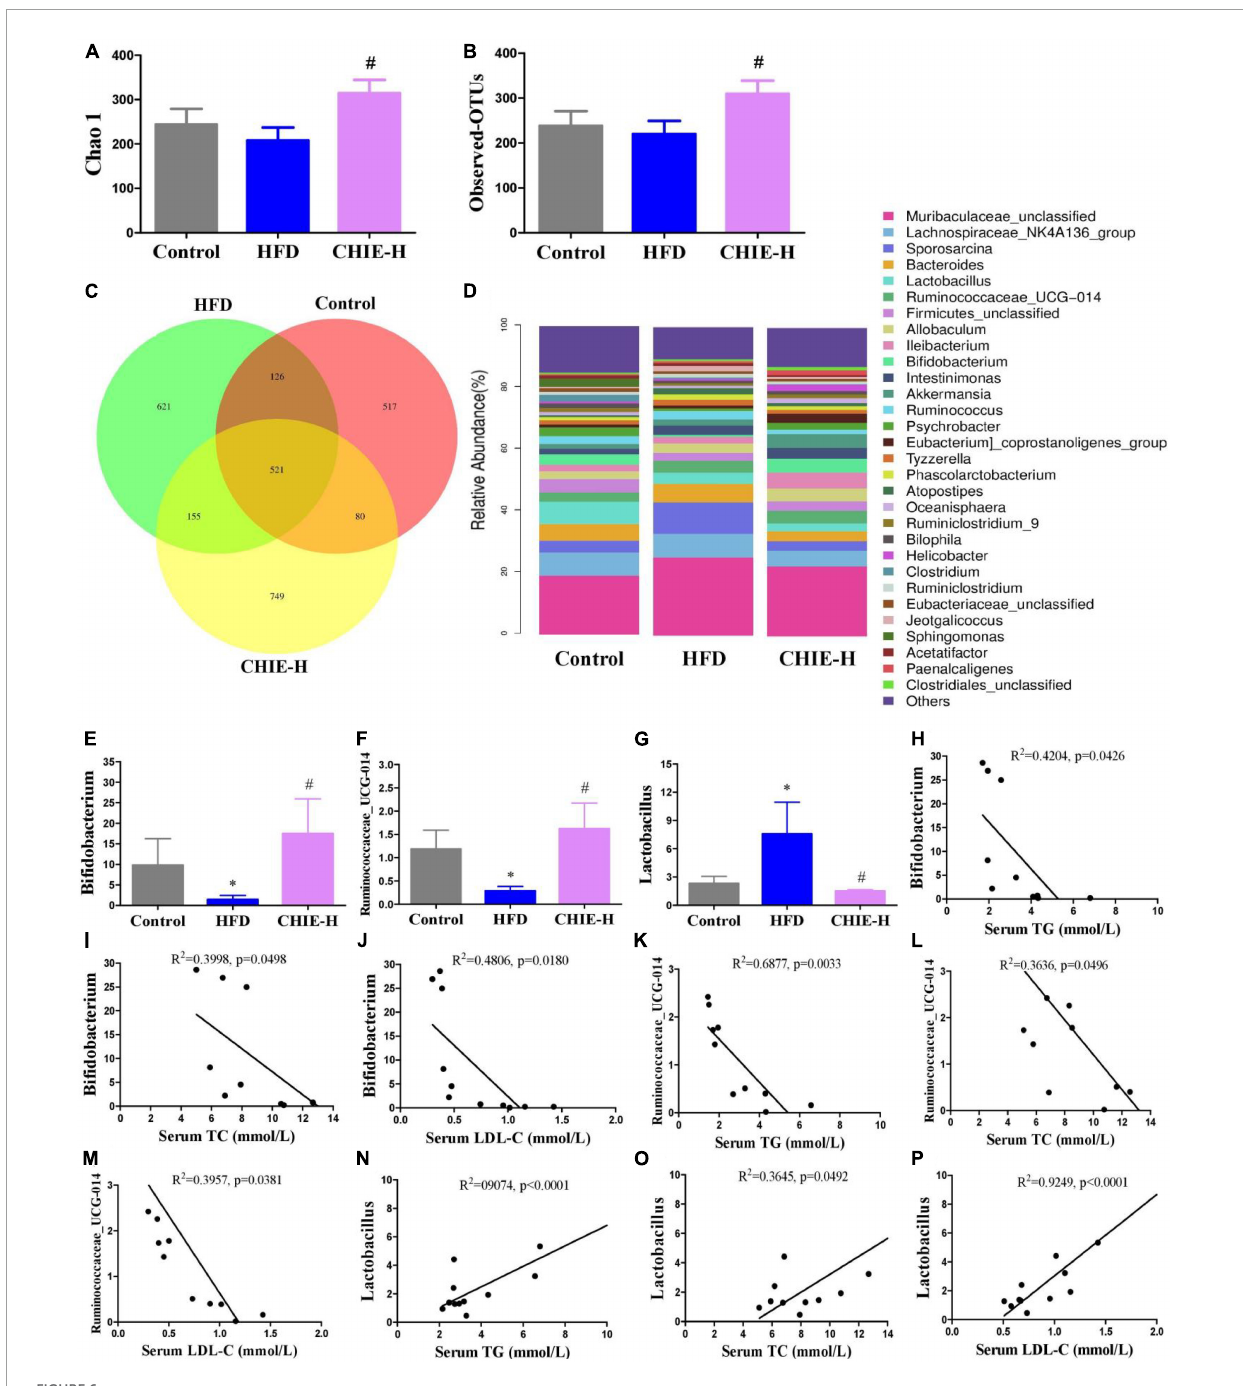
FIGURE6 Effects of CHIE on gut microbiota in golden hamsters fed a high-fat diet and the correlation analyses between relative abundance of gut microbiota and hyperlipidemia core parameters. Treatments were introduced in animal experiment 5. (A) Chao1 index of alpha-diversity. (B) Observed OTU number. (C) Petal analysis of OTU. (D) Relative abundance of gut microbiota at the genus level (top 30). (E–G) Relative abundance of Bifidobacterium , Ruminococcaceae_UCG-014 and Lactobacillus at the genus level in feces. (H–P) Correlation analyses between the